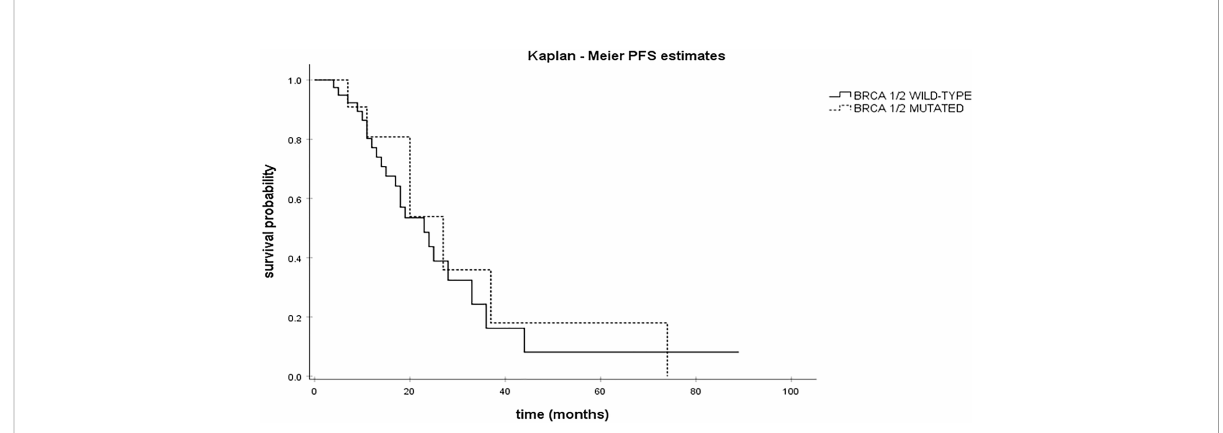
FIGURE 4 Kaplan Meier curves for PFS in BRCA1/2-mutated vs BRCA1/2 wild-type